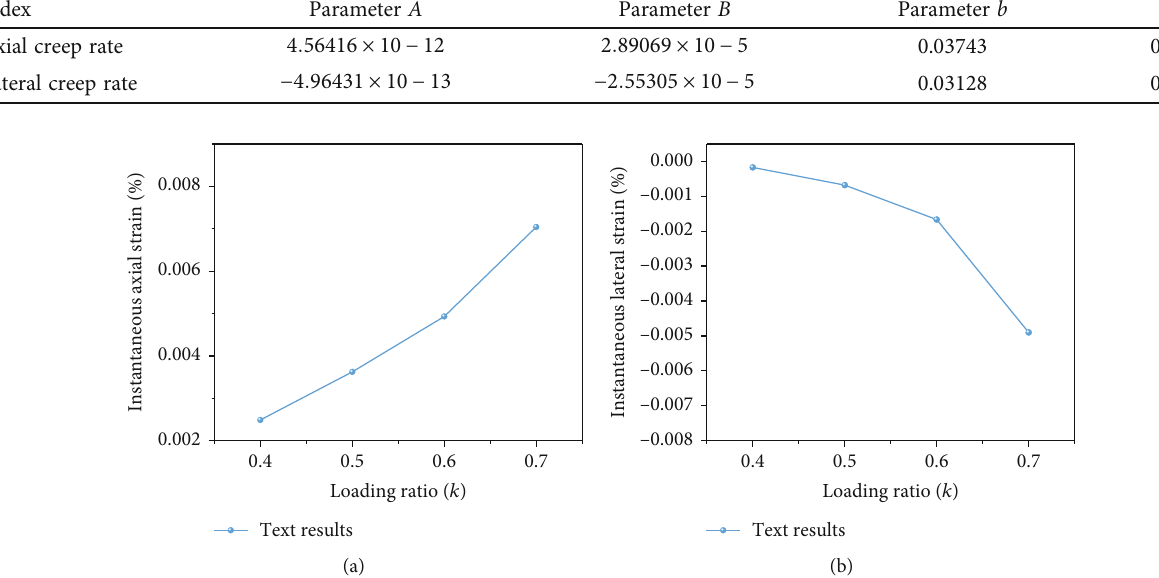
Figure 8: Relationship between the stress level and the instantaneous strain.